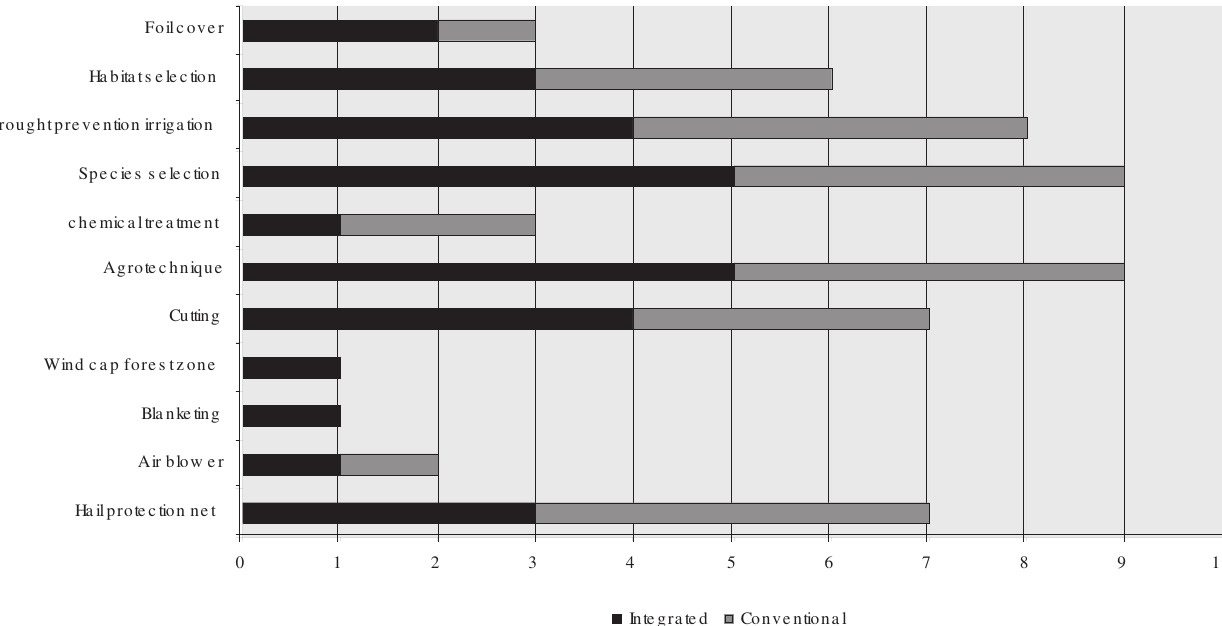
Figure 2. The share of protection technologies applied for preventing damage for various methods of cultivation, in function (%) of the valid answers, 2010 p=0.000, p ≤ 0.05 Source: On the basis of empirical research